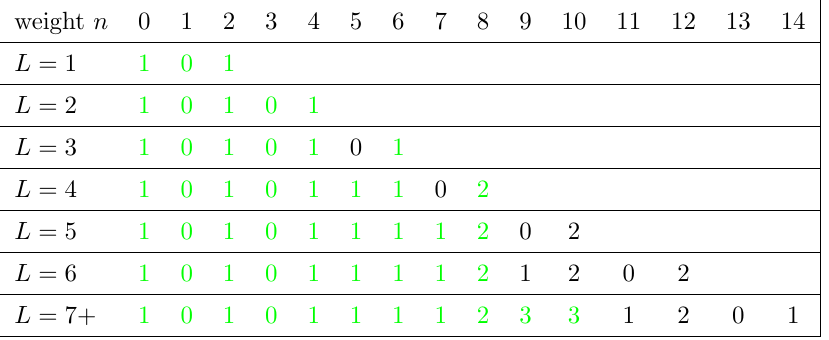
Table 7 . Same as table 4, but just the space of values of f n; 1 ; 1 ; : : : ; 1 g coproducts of the MHV and NMHV amplitudes at (1 ; 1 ; 1). Saturation of H hex (1 ; 1 ; 1) is achieved through weight